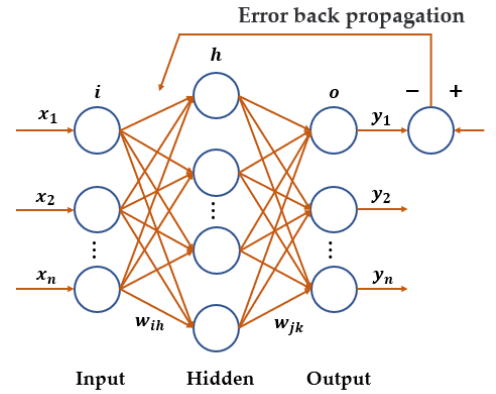
Figure 1. Schematic diagram of BP neural network with one hidden layer where x n is the current input; i is the input layer; h is the hidden layer; w ih and w jk are the weight matrix of the hidden layer; o is the output layer and y n is the current output.